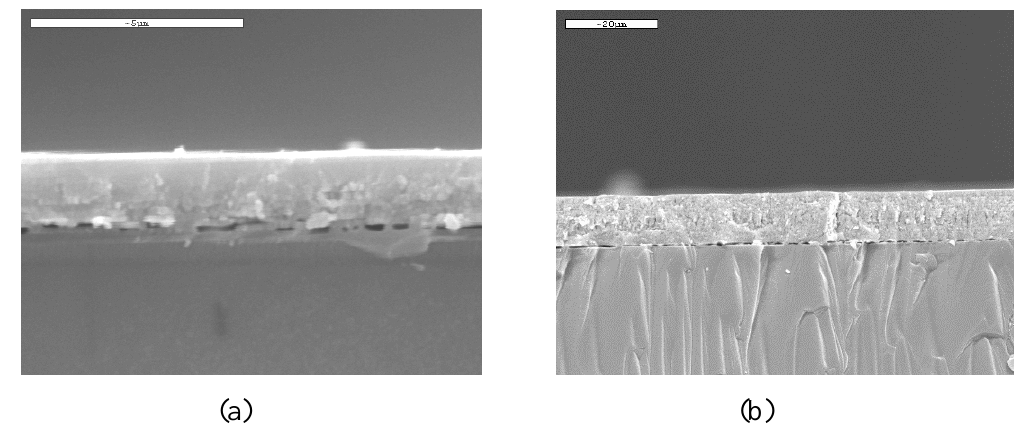
Figure 4. Cross-sectional SEM image: (a) 2 µ m-thick PZT film (scale bar represents 5 µ m); (b) 10 µ m-thick PZT film (scale bar represents 20 µ